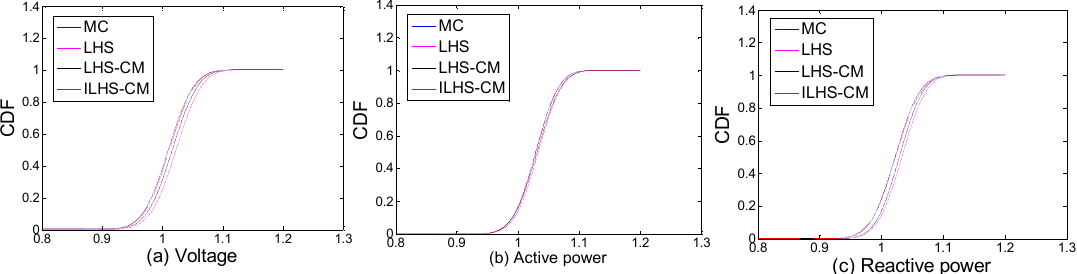
Figure 5. Output variables CDF; ( a ) Voltage amplitude of Node 30 ( b ) Active power of Branch 29–30